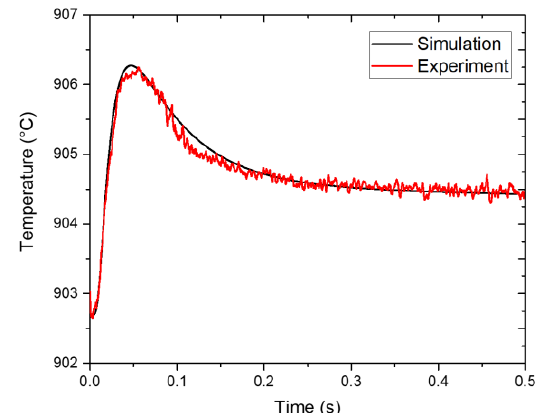
Fig. 4. On-axis surface temperature measured (red line) as a function of time and model thermogram (black line) obtained via least square optimization